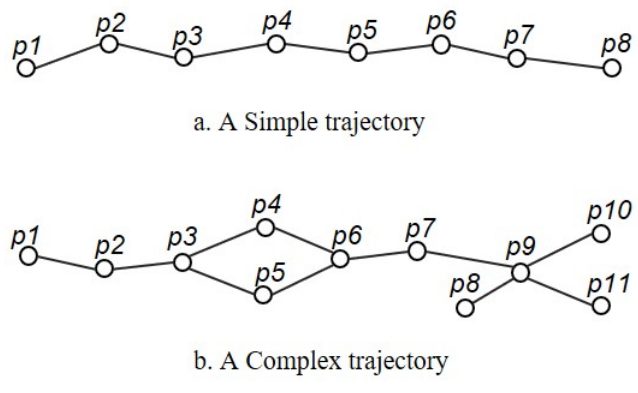
Figure 1. ( a ) A simple trajectory and ( b ) a complex trajectory.